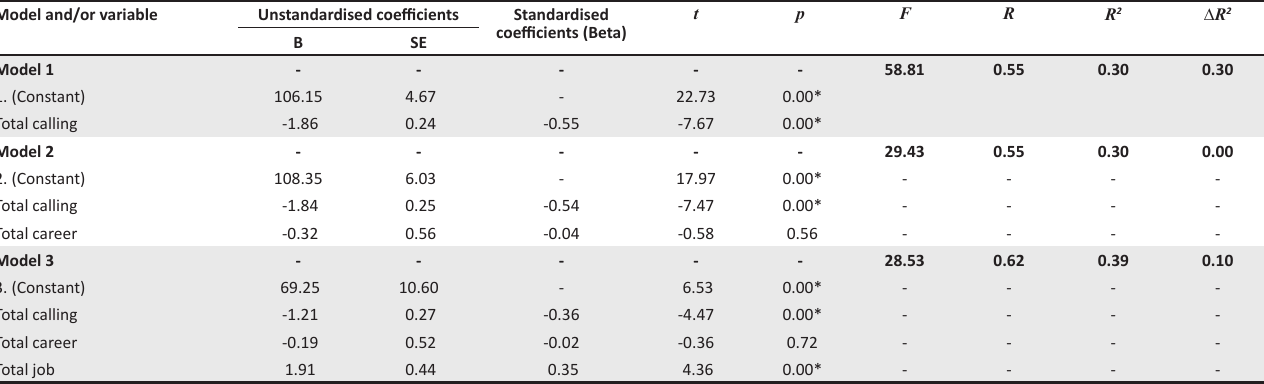
TABLE 3: Regression analyses with meaning of work (job, career or calling) as the independent variable and work engagement as the dependent variable. Model and/or variable